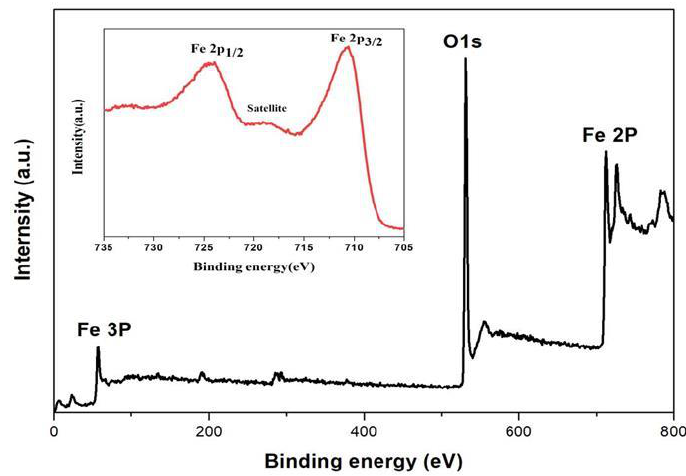
Figure 3. XPS survey and Fe 2p spectra (inset) of the amorphous sample (A1h).